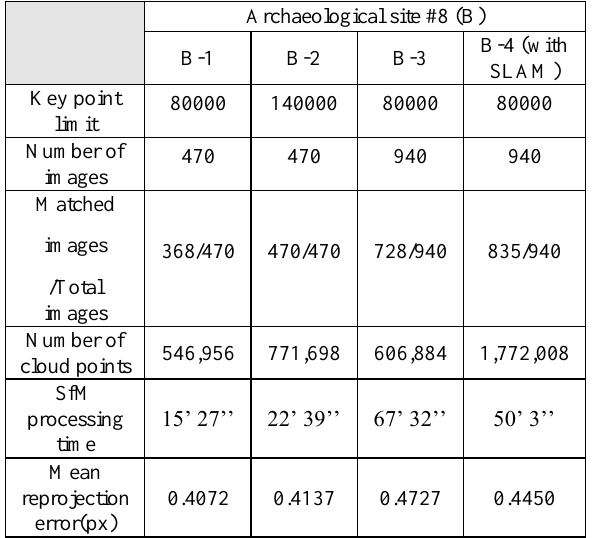
Table 3. Results of SfM with SLAM (with dataset B)